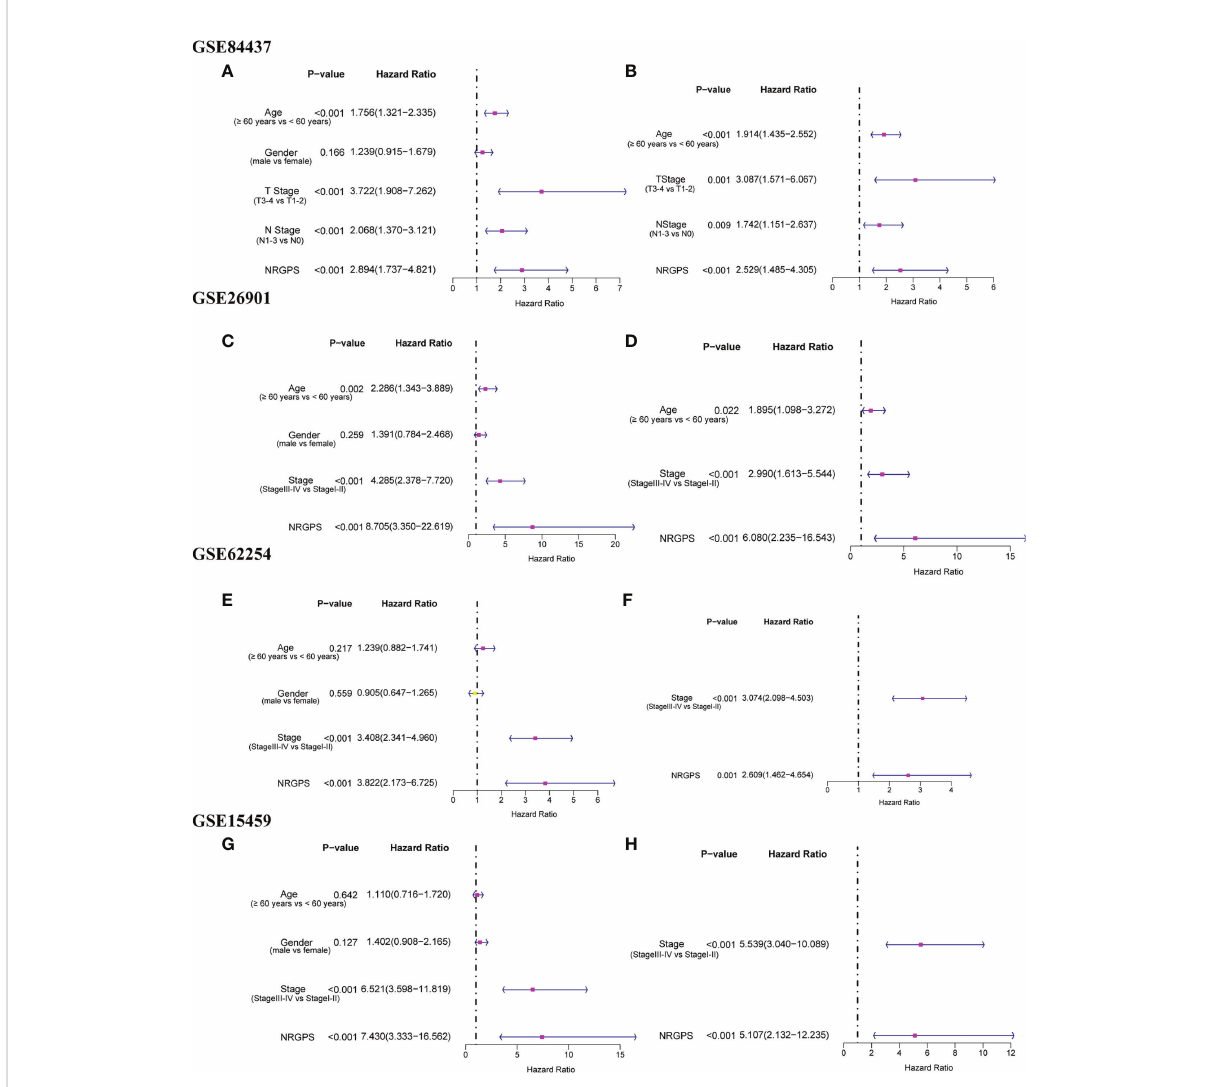
FIGURE 6 Independent prognostic analysis of prognostic model in GEO validation cohorts was performed. The forestplot of univariable Cox regression analysis of NRGPS and clinical characteristics in (A) GSE84437, (C) GSE62901, (E) GSE62254, (G) GSE15459. The forestplot of multivariable Cox regression analysis of NRGPS and clinical characteristics in (B) GSE84437, (D) GSE62901, (F) GSE62254, (H) GSE15459. NRGPS,necroptosis- related gene prognostic